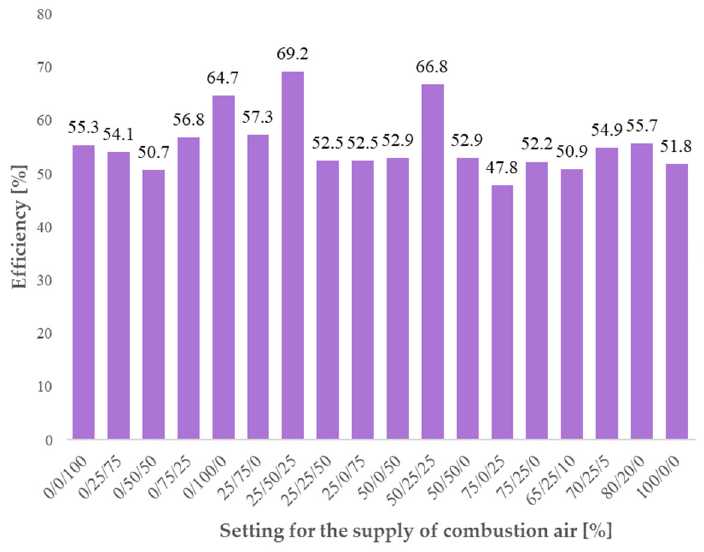
Figure 3. The efficiency comparison during different settings for air supply.